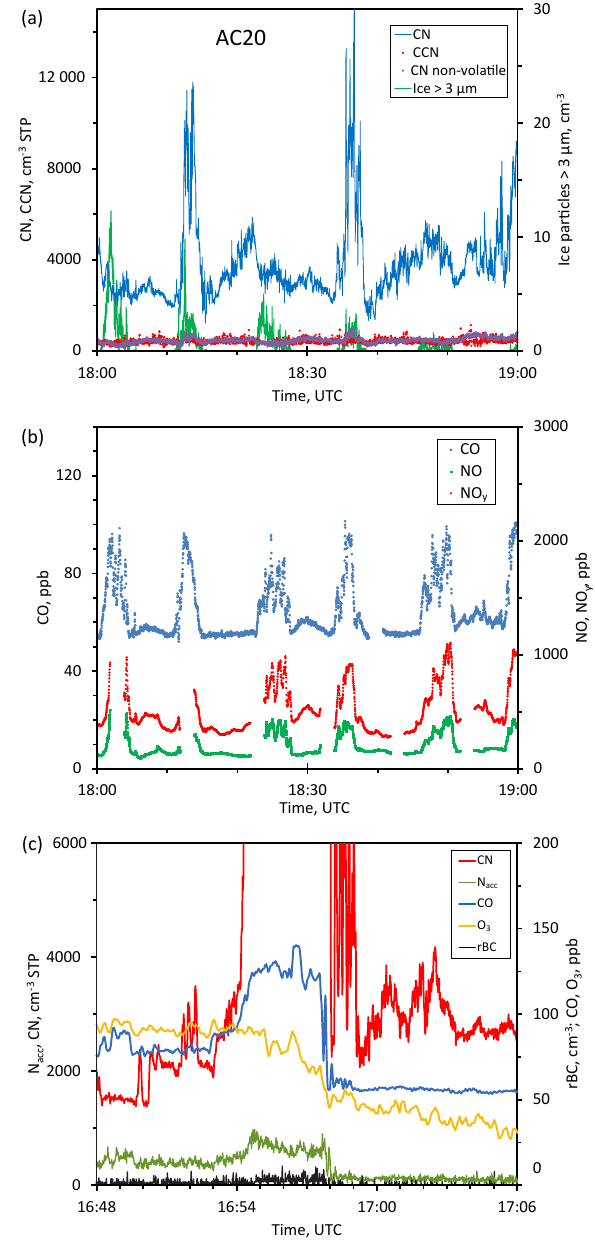
Figure 23. (a) Measurements of N CCN0 . 5 , N CN , N nonvol , and ice particles during cloud top penetrations on flight AC20 at altitudes between 12.3 and 13.5km. (b) Concentrations of CO, NO, and NO y on the same flight segments. (c) Measurements of N acc , N CN , rBC, CO, and O 3 during the climb from 11.0 to